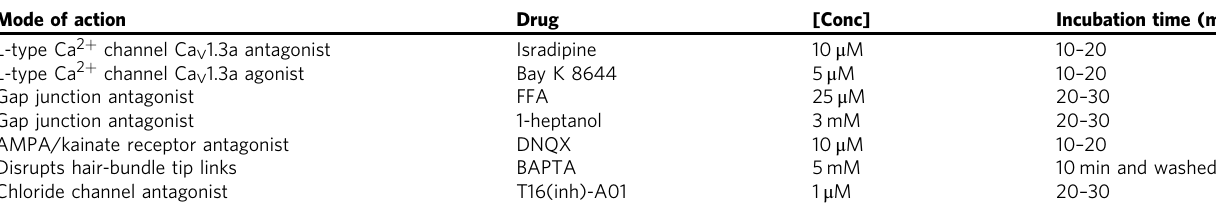
Table 1 Pharmacological compounds utilized in the study Mode of